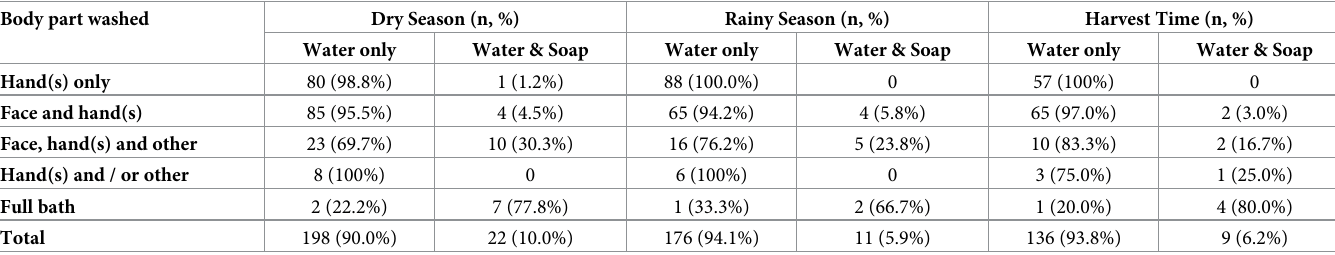
Table shows row percentages for each season. Data reported are for a comparable time period from 06:30h to 17:30h on Day 1 and from 06:30h to 09:30h on Day 2.